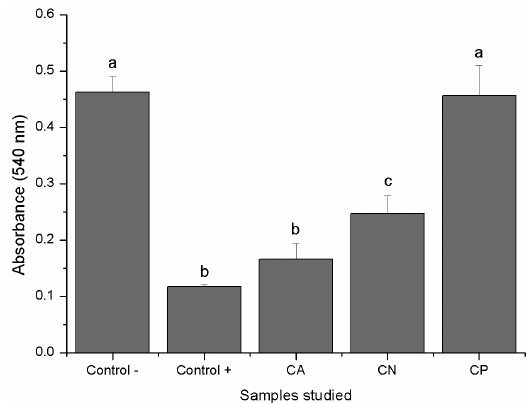
Figure 4. Direct cytotoxicity test for chitosan substrates. Our results indicated direct toxicity of CA membrane. Different letters indicate significantly different means ( p <